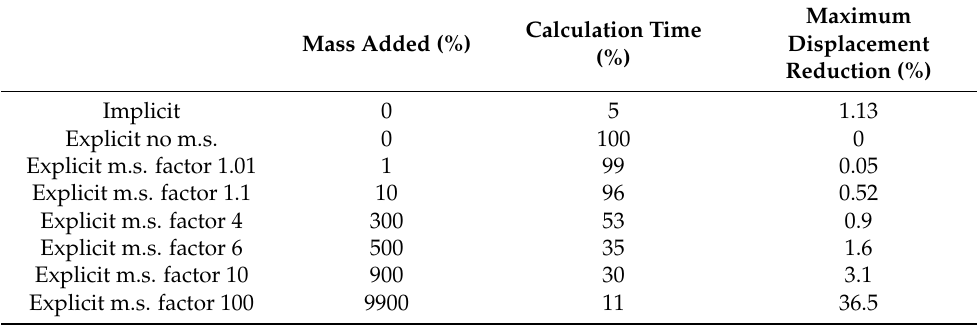
Table 3. Computational time in percent relative to the dynamic explicit simulation without mass scaling (m.s.) for both algorithms and incorporating different m.s. factors.